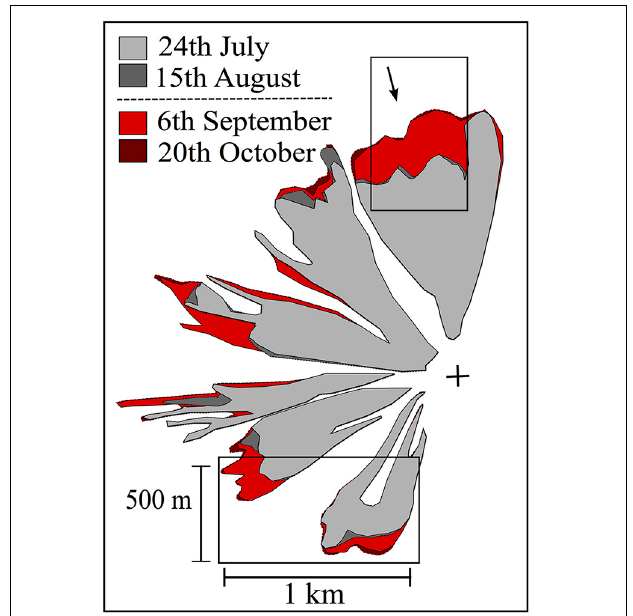
FIGURE 7 | Outlines of areas of intensity change attributed to rock fall between 02.07.2012 and 4 later images. Pre-earthquake extent of rockfall is outlined in gray, rockfall extents from images that spanned the earthquake are